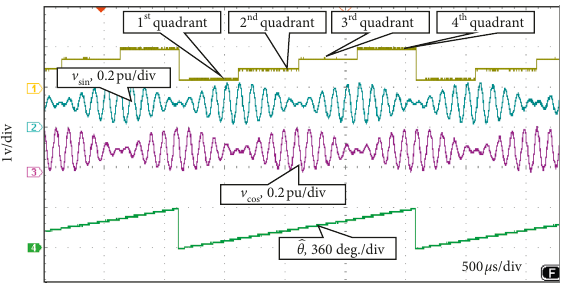
Figure 12: Waveform at 8000rpm rotation speed.